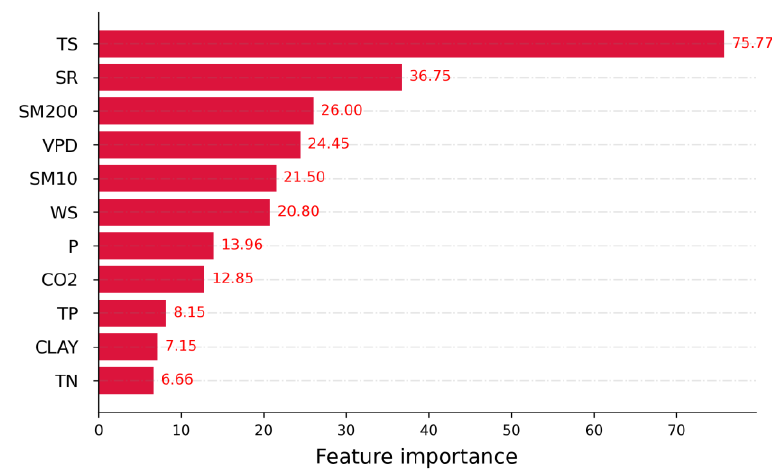
Figure 5. Feature importance plot. The feature importance was quantified as the average of absolute SHAP values (mean |SHAP values|) of all 0.05° × 0.05° pixels. Units of SHAP values: g C/m².